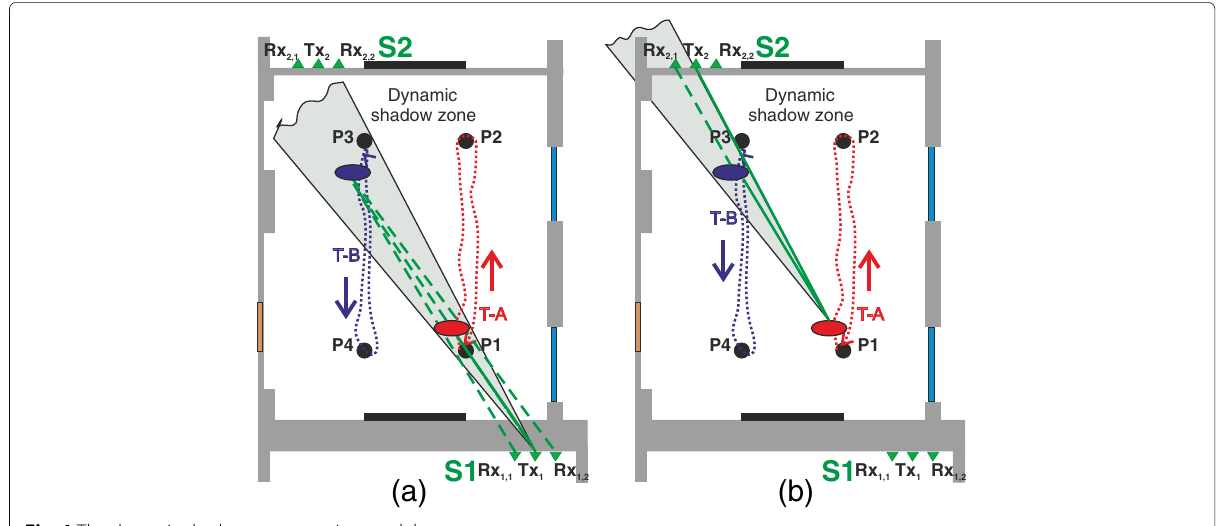
Fig. 1 The dynamic shadow zone creation model